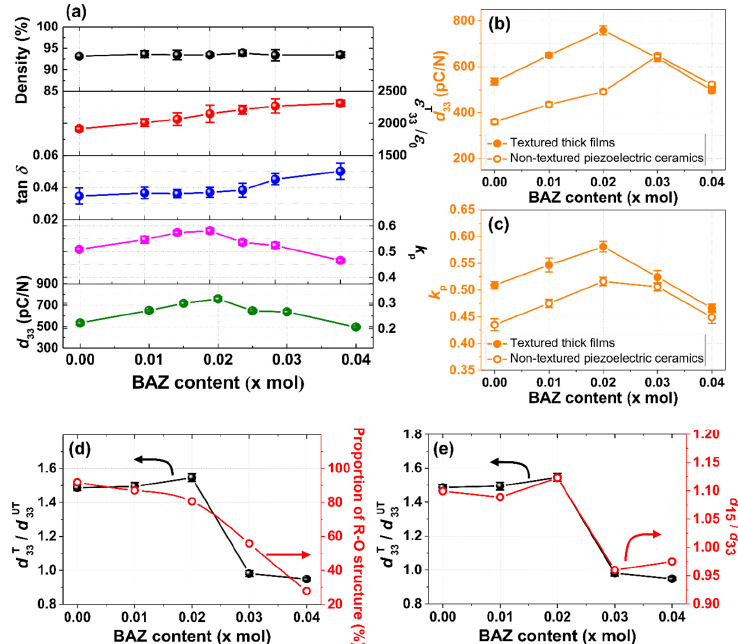
Figure 8. ( a ) Relative densities, ε T33 / ε 0 , tan δ , k p and d 33 values of the textured NKNS ‐ (0.04 − x)SZ ‐ Figure 8. ( a ) Relative densities, ε T 33 / ε 0 , tan δ , k p and d 33 values of the textured NKNS-(0.04 − x)SZ- xBAZ thick films (0.0 ≤ x ≤ 0.04). ( b ) The d 33 values and ( c ) k p values of the textured NKNS ‐ (0.04 − x)SZ ‐ xBAZ thick films (0.0 ≤ x ≤ 0.04). ( b ) The d 33 values and ( c ) k p values of the textured NKNS- xBAZ thick films and untextured piezoelectric ceramics with 0.0 ≤ x ≤ 0.04. ( d ) Proportion of the R ‐ O structure and d 33T / d 33UT values of the NKNS ‐ (0.04 − x)SZ ‐ xBAZ thick films (0.0 ≤ x ≤ 0.04). ( e ) d 15 / d 33 (0.04 − x)SZ-xBAZ thick films and untextured piezoelectric ceramics with 0.0 ≤ x ≤ 0.04. ( d ) Pro- of the NKNS ‐ (0.04 − x)SZ ‐ xBAZ piezoelectric ceramics and d 33T / d 33UT of the NKNS ‐ (0.04 − x)SZ ‐ xBAZ portion of the R-O structure and d 33T / d 33UT values of the NKNS-(0.04 − x)SZ-xBAZ thick films thick films (0.0 ≤ x ≤ 0.04). (0.0 ≤ x ≤ 0.04). ( e ) d 15 / d 33 of the NKNS-(0.04 − x)SZ-xBAZ piezoelectric ceramics and d 33 T / d 33 UT of However, the d 33 value decreased when x was > 0.02. Hence, it can be proposed that the NKNS-(0.04 − x)SZ-xBAZ thick films (0.0 ≤ x ≤ 0.04). the variation in d 33 with respect to x was similar to the k p value. Moreover, the highest piezoelectricity ( d 33 = 760 ± 20 pC/N and k p = 0.58) was observed for the textured thick film Piezoelectric single crystals with O and R structures, which are grown along polar with x = 0.02. According to a previous study, an untextured piezoelectric ceramic with x = directions, generally show large d 15 / d 33 values (or shear piezoelectric constants) when sub- 0.03 showed the largest piezoelectricity ( d 33 = 650 pC/N and k p = 0.5) [20]. However, the jected to an applied electric field along the polar direction [33]. When these single textured thick film with x = 0.03 showed a slightly reduced d 33 value of ~638 pC/N with a slightly increased k p value of 0.52, indicating that the increase in the piezoelectricity of this thick film was not significant after texturing. The increase in the piezoelectricity after texturing was investigated for the NKNS ‐ (0.04 − x)SZ ‐ xBAZ thick films (0.0 ≤ x ≤ 0.04). Figure 8b shows the d 33 values of the textured NKNS ‐ (0.04 − x)SZ ‐ xBAZ thick films and untextured piezoelectric ceramics with 0.0 ≤ x ≤ 0.04. The d 33 values of the textured thick films were much larger than those of untextured piezoelectric ceramics for the samples with 0.0 ≤ x ≤ 0.02; the d 33 values of the textured thick films were ~1.55 times larger than those of the untextured piezoelectric ceramics. However, the d 33 values of the textured thick films were similar to those of the untextured piezoelectric ceramics for the samples with x = 0.03 and 0.04, indicating that the d 33 value was not improved after texturing. The k p values of the textured thick films and untextured piezoelectric ceramics were also studied (Figure 8c). The k p values of the textured thick films were much larger than those of the untextured piezoelectric ceramics for the samples with 0.0 ≤ x ≤ 0.02. However, for the samples with x = 0.03 and 0.04, the enhancement in the k p value after texturing was not significant. Hence, the d 33 and k p values show a similar trend; the effect of texturing on the